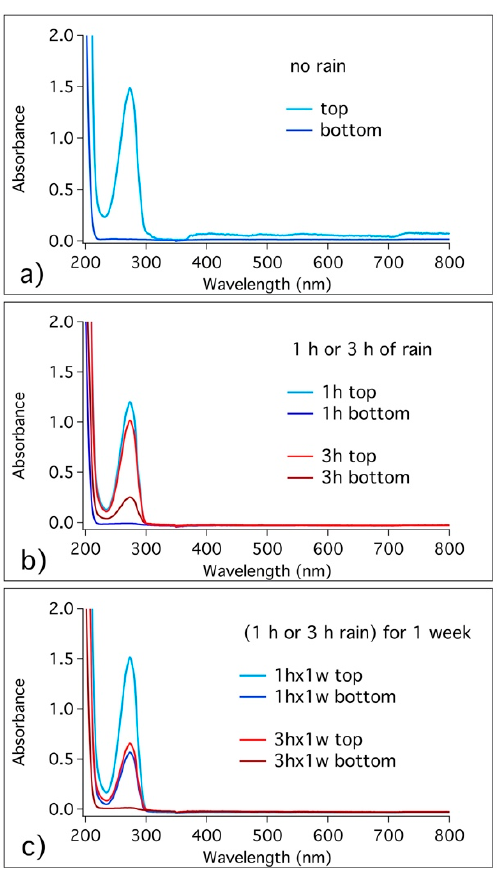
Figure 9. UV-vis spectra of the top and bottom piece solutions for surface coated surfaces under different conditions of rain: ( a ) no rain; ( b ) 1 h and 3 h of moderate rain; ( c ) 1 h and 3 h of moderate rain repeated for 1 week.